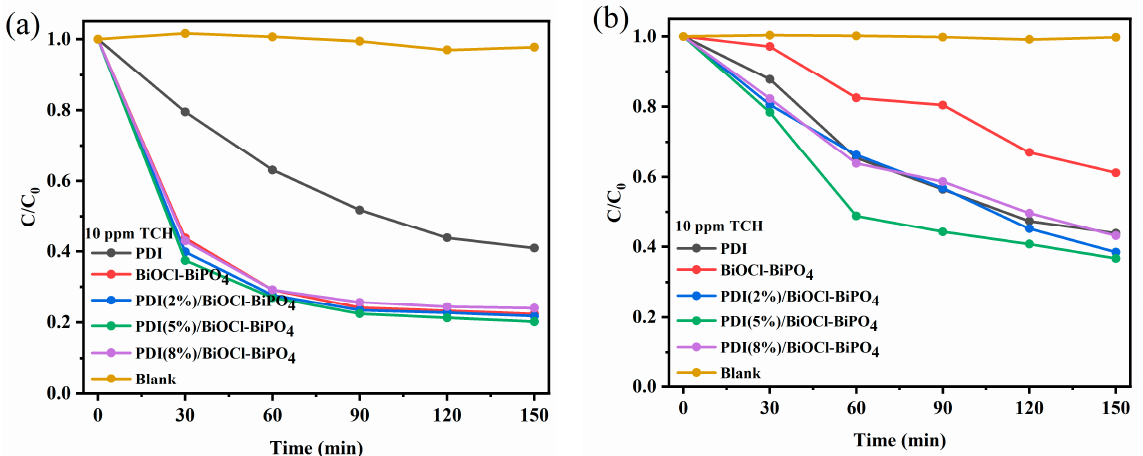
Figure 6. The photocatalytic activity of tetracycline hydrochloride degradation for PDI, BiOCl-BiPO 4 , PDI(2%)/BiOCl-BiPO 4 , PDI(5%)/BiOCl-BiPO 4 and PDI(8%)/BiOCl-BiPO 4 samples as a function of irradiation time ( a ) under simulated solar light irradiation ( b ) under visible light irradiation.